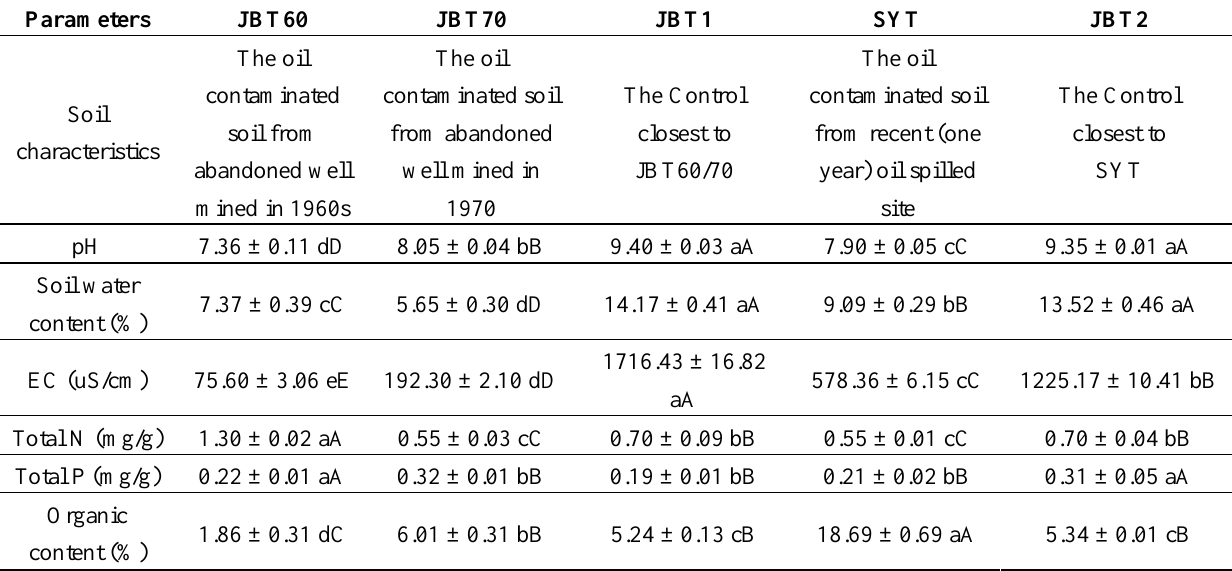
Table 1. The basic properties of the soil samples used in this study.